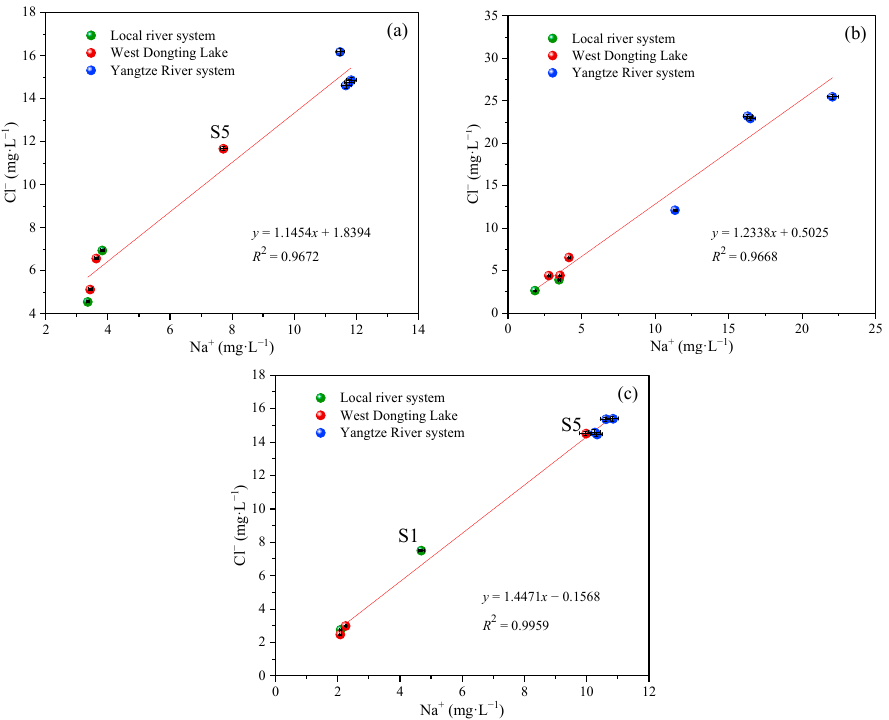
Figure 3. The correspondence relations of the concentrations of Na + and Cl − in the dry season ( a ), in the normal season ( b ) and in the wet season ( c ), respectively.